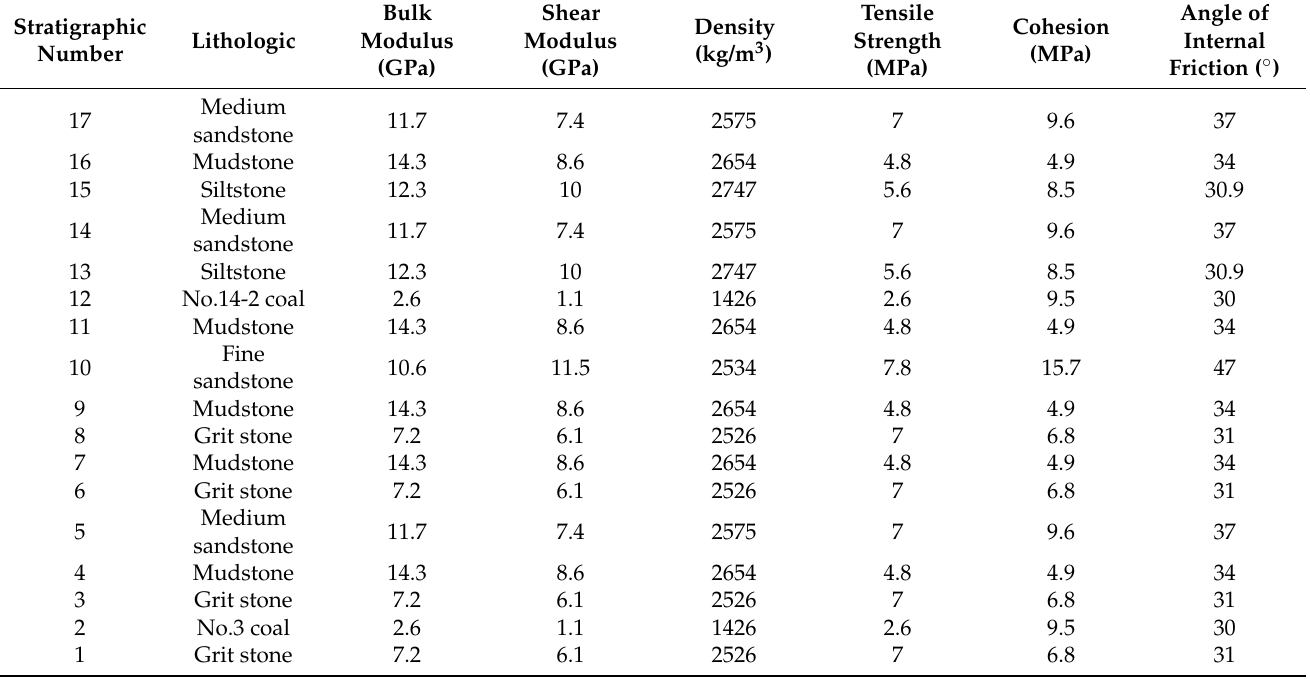
Table 1. Table of mechanical parameters of model overburden.